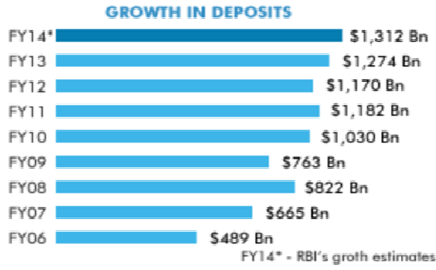
Figure 1: Rise in Bank Deposits from